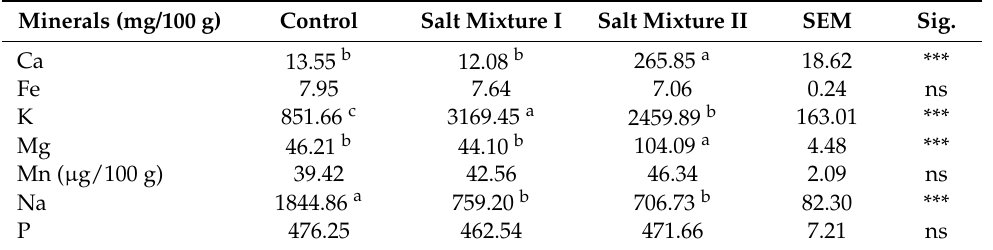
Table 2. Effect of NaCl replacement by other chloride salts on the mineral content of dry-cured deer